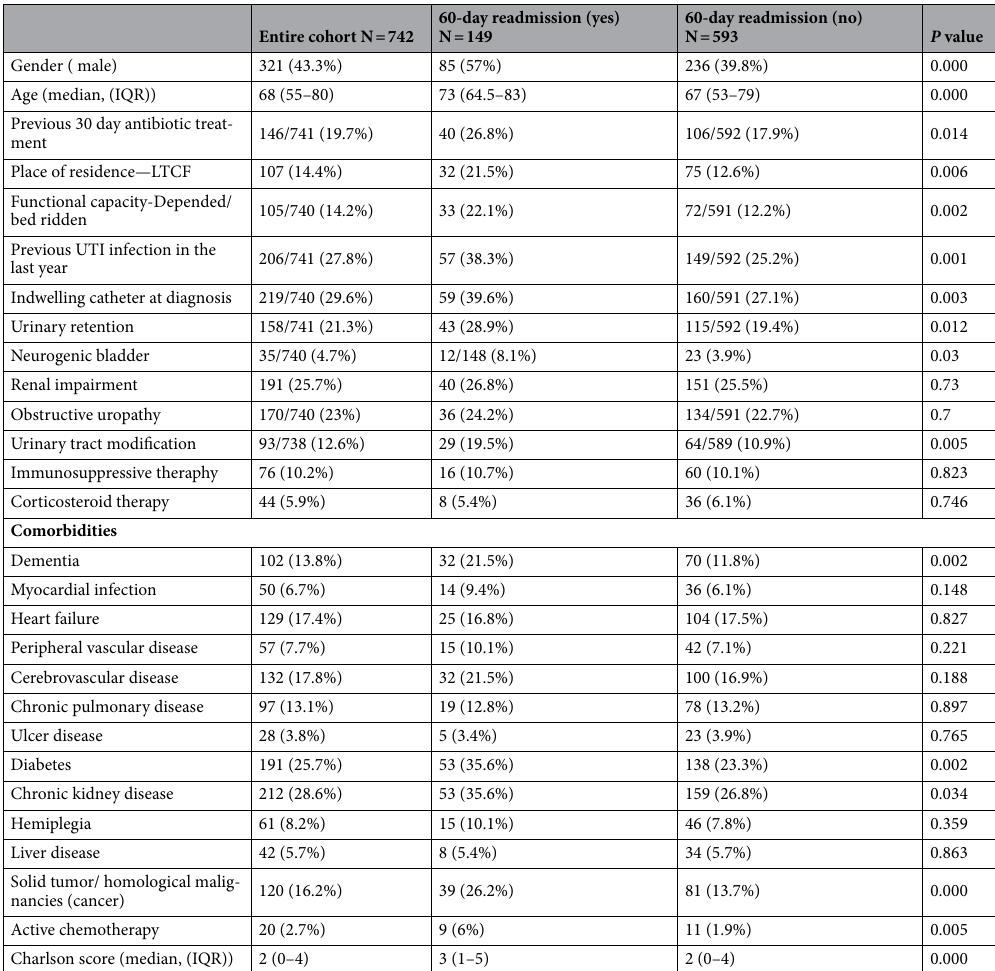
Table 1. Patient characteristics for 60-day readmission. Abbreviations: UTI, urinary tract infection; LTCF, long term care Facility;